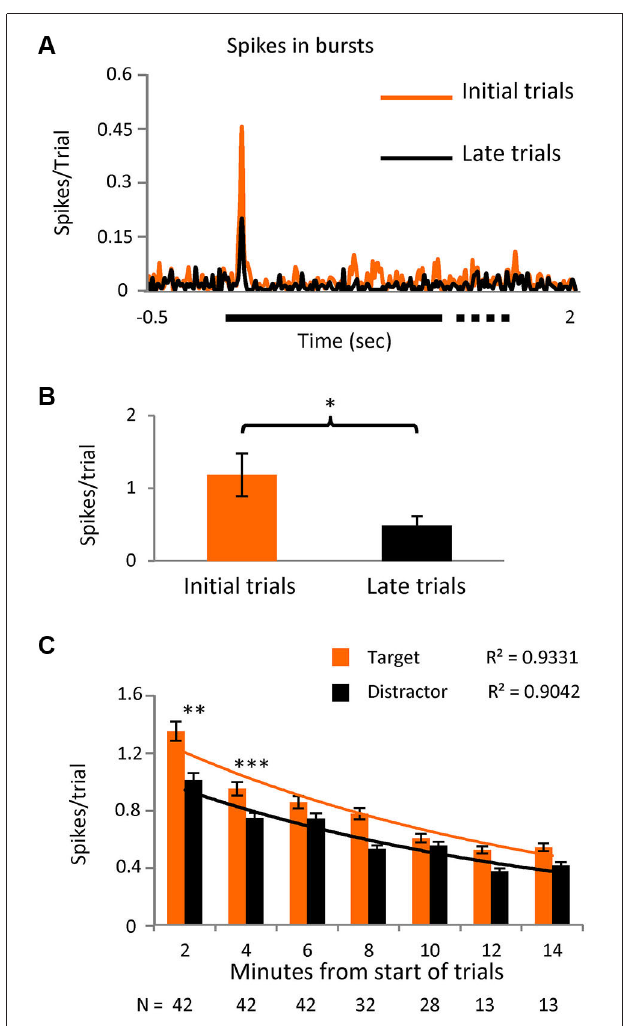
FIGURE 4 | Initial stimuli evoke more burst responses. (A) PSTH showing the spikes in bursts in the initial part of the task (first third of the trials) and for the later part (last third) in a subset of cells ( n = 12) where the number of trials was greater than 40 ( p < 0.05). Bin size = 10 ms. (B) Averaged number of spikes in bursts during the initial 20 to 80 ms interval after stimulus presentation in the same subgroup. (C) Spikes in bursts with respect to time since the onset of the task, shown as spikes/trial ± SEM and separated into responses to the novel and distractor stimuli. Note that most cells were only tested over 8 min (values below the columns) as outlined in the text describing Figure 3A . An exponential decay curve is shown for both the novel stimuli and the distractor, with the goodness-of-fit values ( r 2 ) given above the traces. The differences between novel and distractor responses were significantly different for the 0–2 and 2–4 min groups (Kolmogorov-Smirnoff test; p < 0.005 and p < 0.0005 respectively).